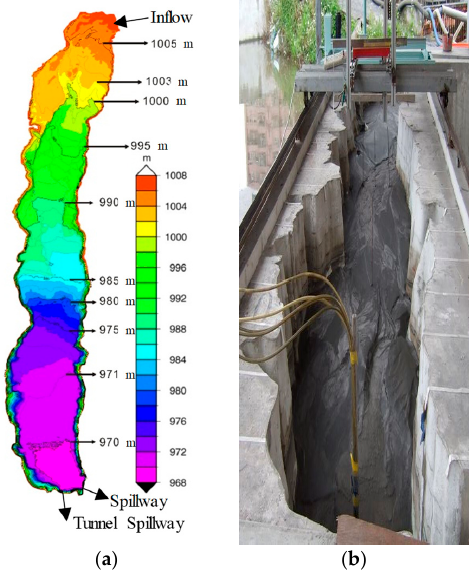
Figure 3. ( a ) Bed elevation of the Wushe Reservoir; ( b ) physical model.